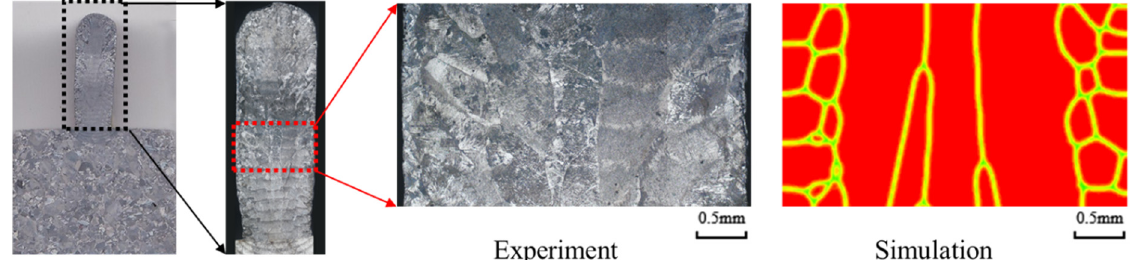
Figure 5. Comparison of phase field model and experimental observation [106]. (Reprinted/adapted with permission from Ref. [106], 2020, Elsevier).